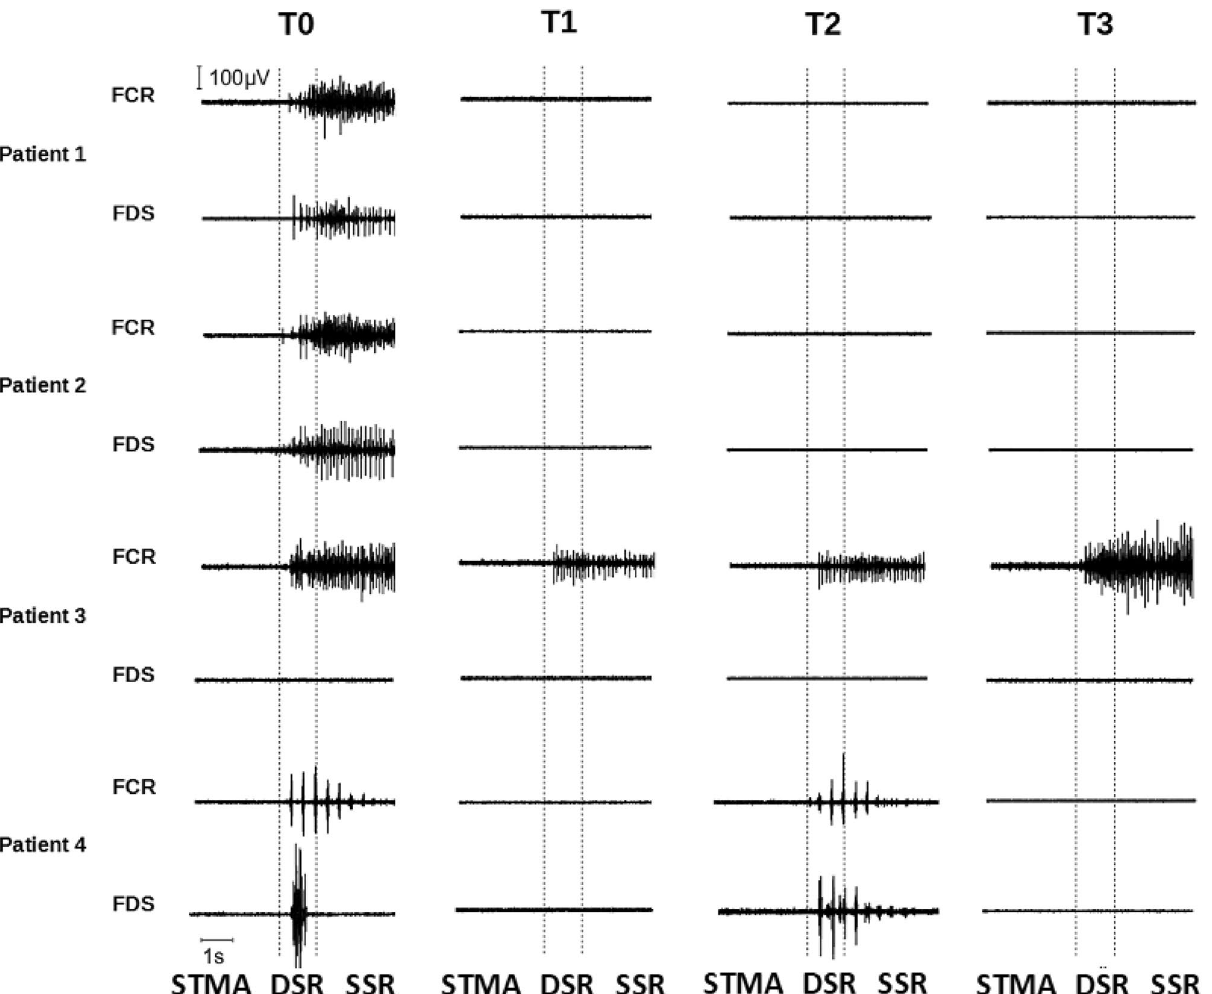
Figure 3. EMG activity of Flexor Carpi Radialis (FCR) and Flexor Digitorum Superficialis (FDS) produced by passive stretching in the four patients of the experimental group. First vertical dotted line indicates the start of passive stretch of the wrist and fingers, while the second vertical dotted line indicates the end of passive stretch. Spontaneous Tonic Muscle Activity (STMA) is before the first line, Dynamic Stretch Reflex (DSR) is between the two lines, and Static Stretch Reflex (SSR) is after the second line (see “Stretch reflex assessment and measurement”). No EMG activity was detected prior to passive stretch in any patient (i.e., STMA was not found in any patient). Spasticity (i.e., DSR with or without SSR) was present in all 4 patients at T0 in both FCR and FDS, with the exception of patient 3, in whom spasticity was present only in FCR. After treatment (T1), spasticity disappears in patients 1, 2, 4 and decreases in patient